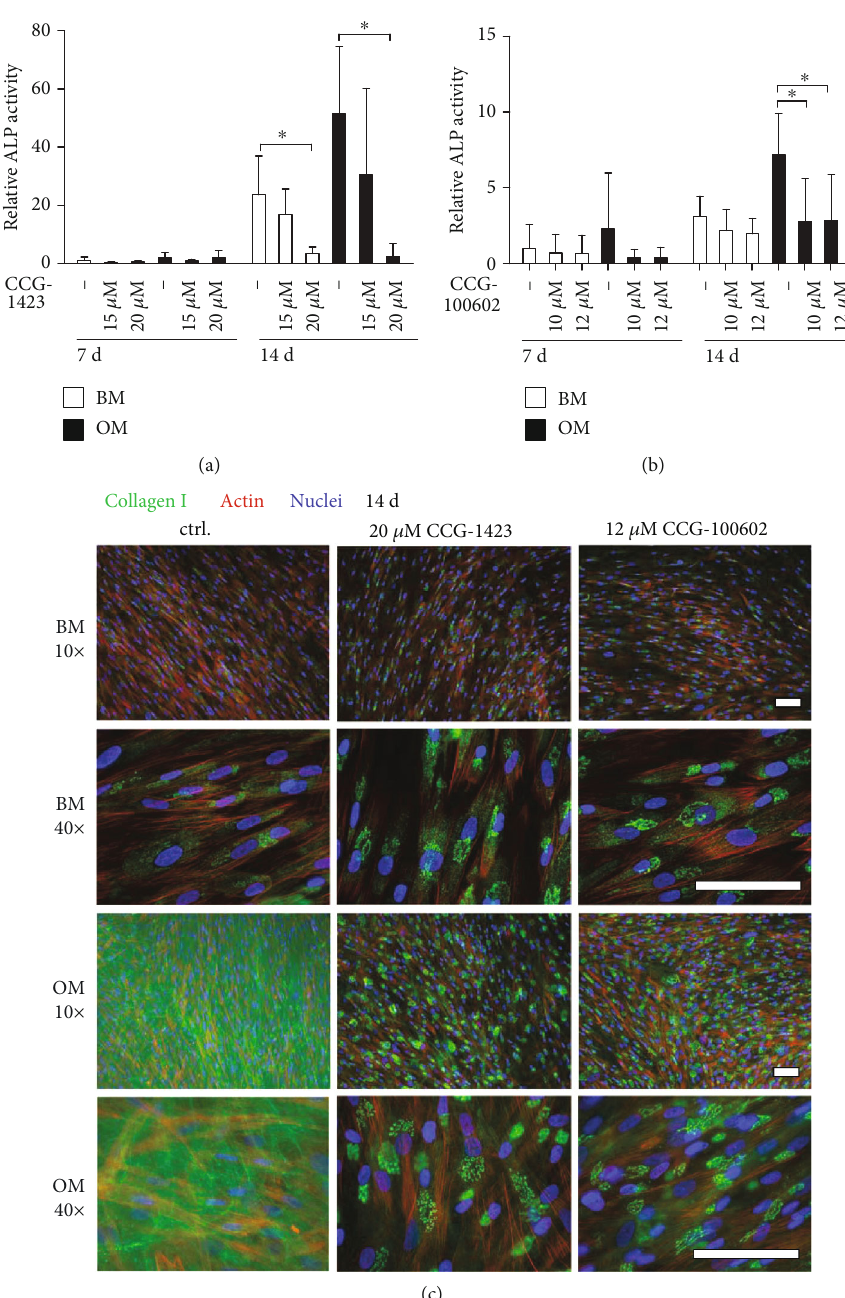
Figure 3: Early osteogenesis of MRTF-A inhibitor-treated hASCs. The hASCs were cultured in BM or OM supplemented with CCG-1423 (a) or CCG-100602 (b) inhibitors in addition to medium controls. ALP activity was analyzed with ALP assay at 7 d and 14 d. The ALP absorbance values were normalized with corresponding CyQUANT results, and the results are presented relative to the 7 d BM sample. N = 12 , independent biological replicates from 4 donors. Signi fi cance level 5%. (c) Representative images of COL-1 (Alexa 488, green)-, actin (Alexa 546, red)-, and nuclei (DAPI, blue)-stained hASCs at 14d, after culture with 20 μ M CCG-1423 or 12 μ M CCG-100602. Images with 10x and 40x magni fi cations are provided to give an overall view and a more detailed view of intracellular localization of COL-1. Scale bars 100 μ m. BM: basic medium; OM: osteogenic